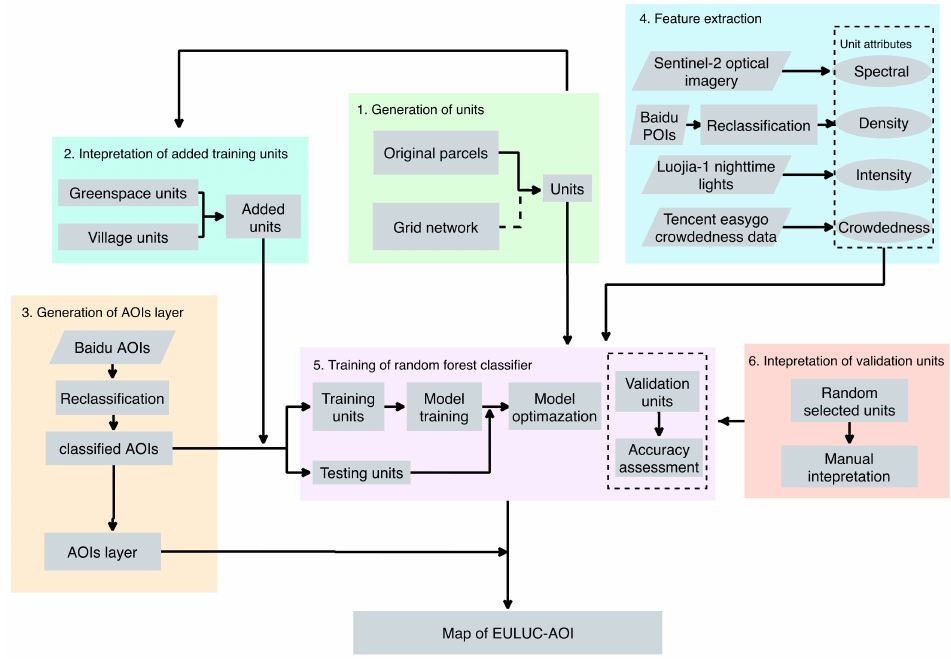
Figure 3. The workflow of the mapping